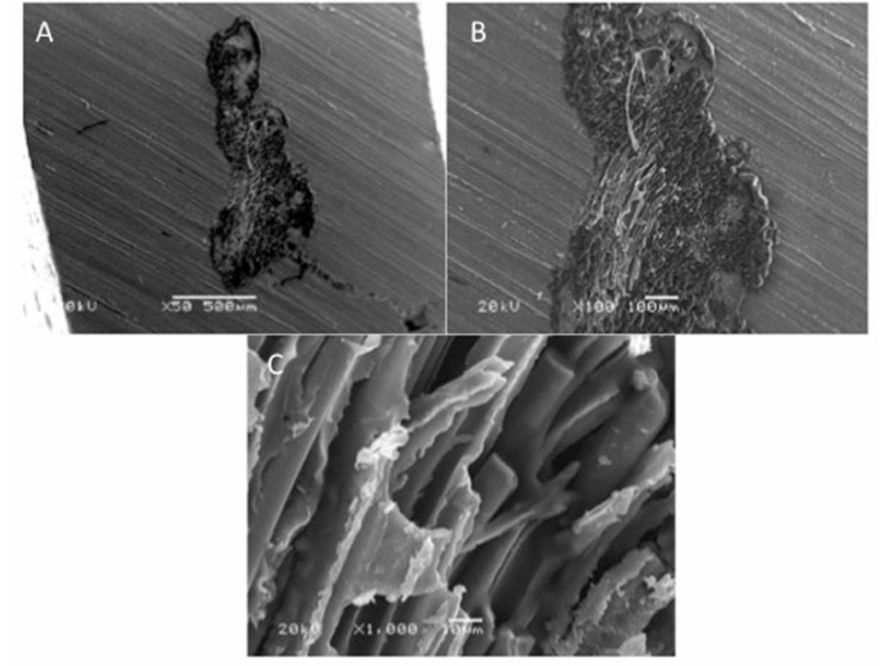
Figure 6. SEM images of OCT fibers (group 3) at ( A ) × 30, ( B ) × 100 and ( C ) × 1000